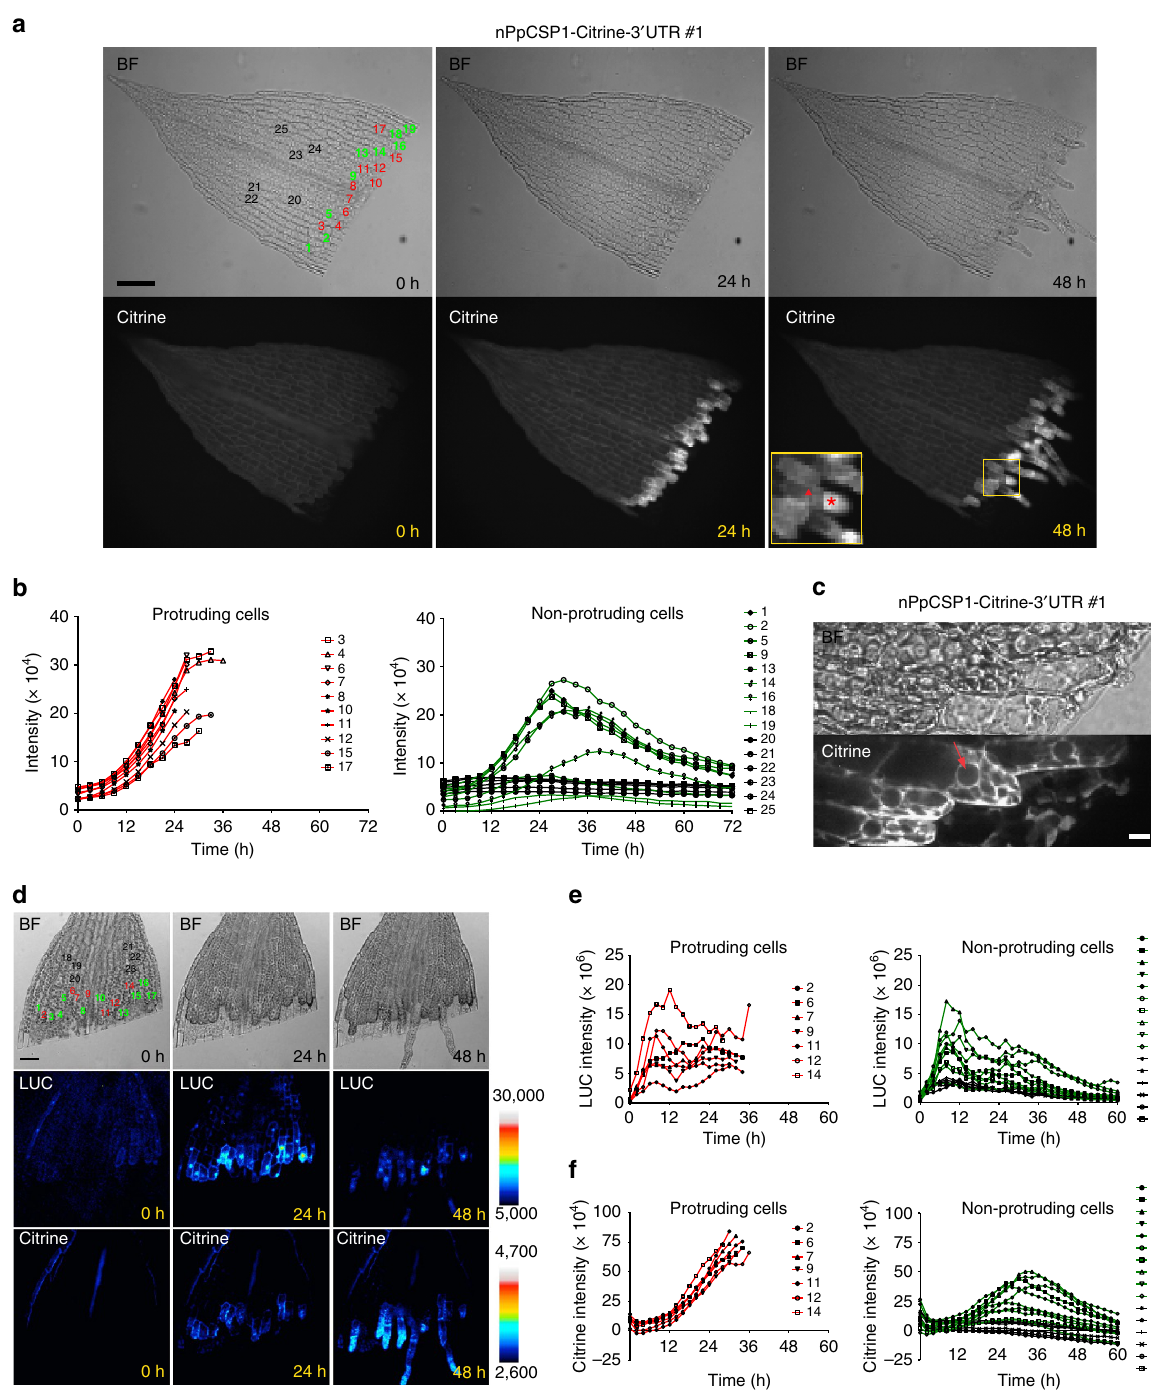
Figure 2 | PpCSP1 is induced in the process of reprogramming. ( a ) Expression pattern of PpCSP1-Citrine in an excised leaf of nPpCSP1-Citrine-3 0 -UTR #1 line. Bright-field (BF) and fluorescent (Citrine) images at 0, 24 and 48h after cutting are shown. Inset red star and triangle indicate a distal chloronema apical stem cell and a proximal chloronema cell, respectively. All edge cells and several non-edge cells were numbered for quantitative analysis in b . See also Supplementary Movie 1. ( b ) The intensity of the Citrine signals in each cell of an excised leaf of nPpCSP1-Citrine-3 0 -UTR #1 (1–25 correspond to cells in the top panel of a ). Red and green lines indicate the signal intensity in edge cells that were and were not reprogrammed into stem cells, respectively. Black lines indicate the signal intensity in non-edge cells that were not reprogrammed into stem cells. ( c ) PpCSP1-Citrine fusion protein localization in excised leaf cells 24h after cutting of the nPpCSP1-Citrine-3 0 -UTR #1 line. Red arrow indicates the nucleus. ( d ) PpCSP1 promoter activity and the protein accumulation during the reprogramming. Bright-field (top), luciferase (middle) and Citrine images (bottom) of an excised leaf of the PpCSP1pro:LUC nPpCSP1-Citrine-3 0 -UTR #2 line at 0, 24 and 48h after cutting. Calibration bars were shown for pseudo-colour images of LUC and Citrine, respectively. All edge cells and several non-edge cells are numbered for e , f . See also Supplementary Movie 4. ( e , f ) The intensity of luciferase ( e ) and Citrine ( f ) signals in each cell (indicated by 1–23 in the top left of d ) in an excised leaf. Red and green lines indicate the signal intensity in edge cells that were and were not reprogrammed into stem cells, respectively. Black lines indicate the signal intensity in non-edge cells that were not reprogrammed into stem cells. Scale bars, 100 m m ( a ); 10 m m ( c ); and 50 m m ( d ). NATURE COMMUNICATIONS|8:14242|DOI: